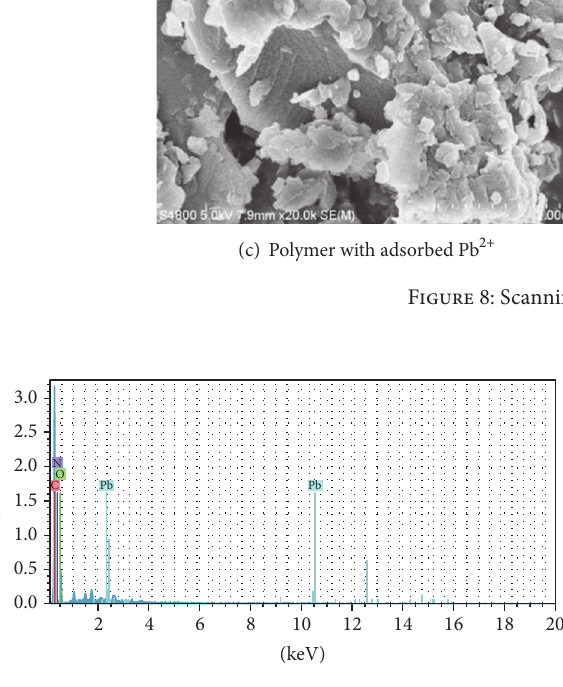
Figure 9: EDX measurement of cross-linked starch xanthate that absorbed Pb 2+ .